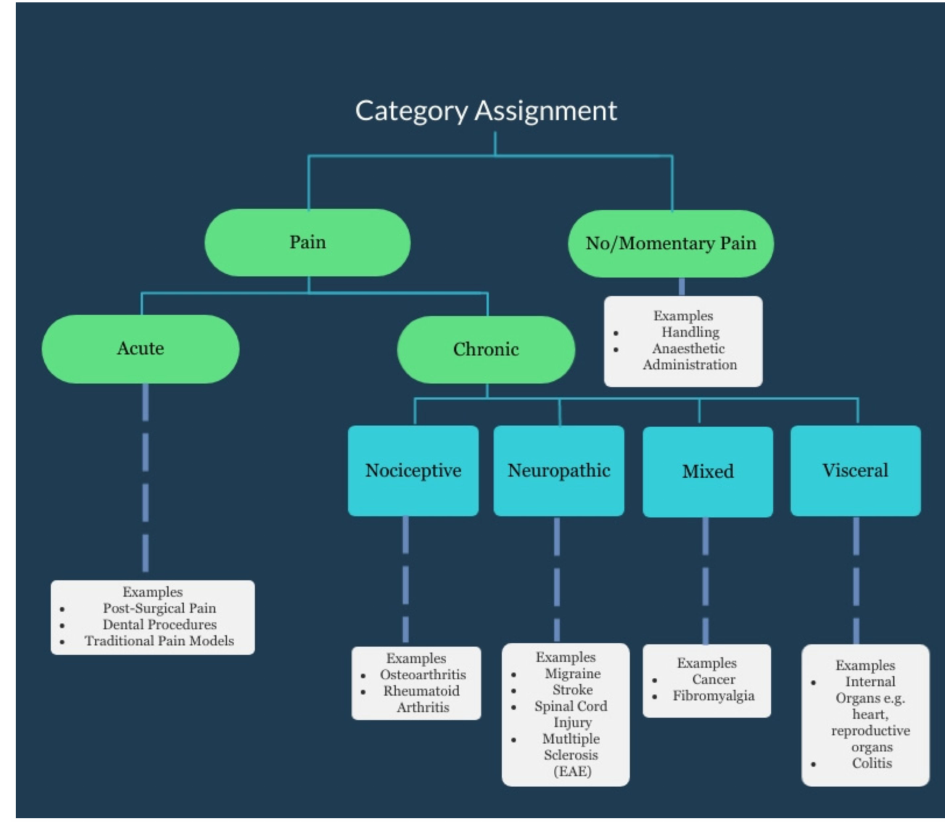
Figure 3. Pain classifications used to guide assignment of studies to categories. Adapted with permission from Springer Nature and Copyright Clearance Center: Springer Nature, Nature Reviews Drug Discovery, Pain Market, Melnikova, COPYRIGHT 2010 [73]. For specific category assignment for included studies, refer to Table